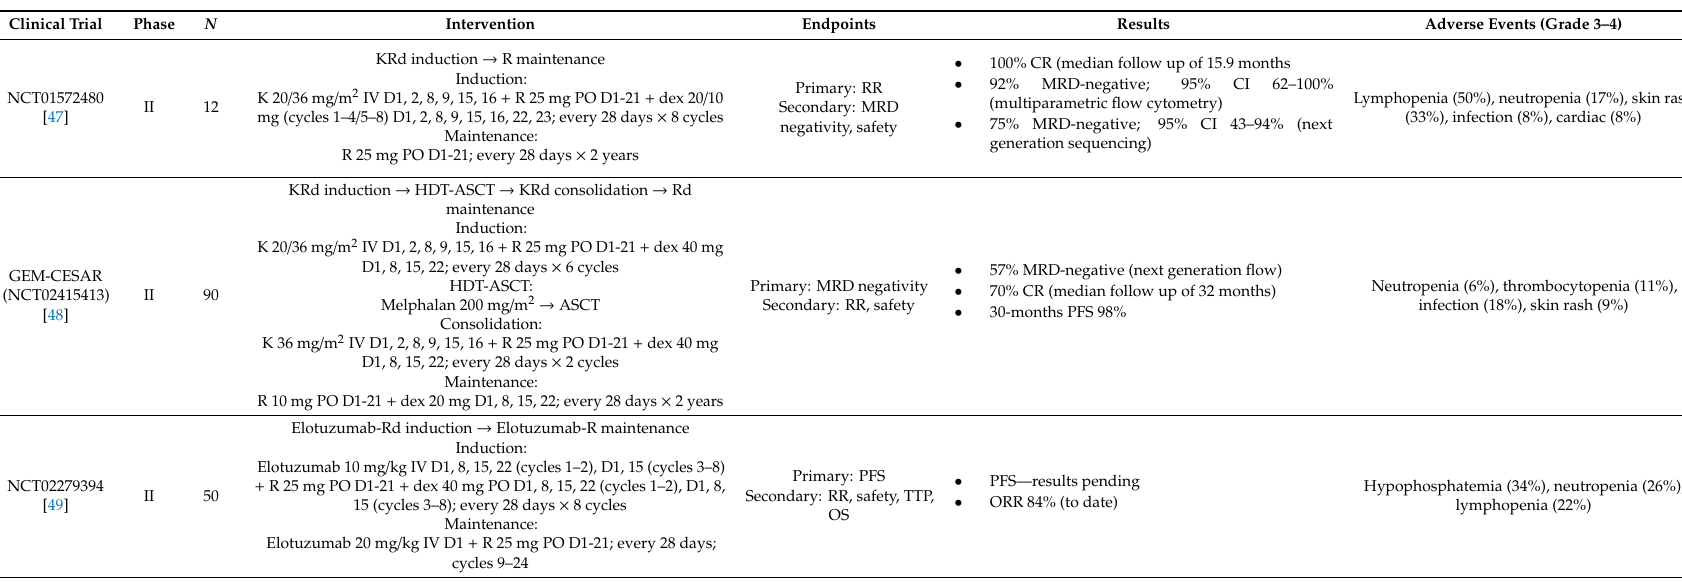
Table 4. Summary of the results of clinical trials investigating early intervention as a treatment strategy in